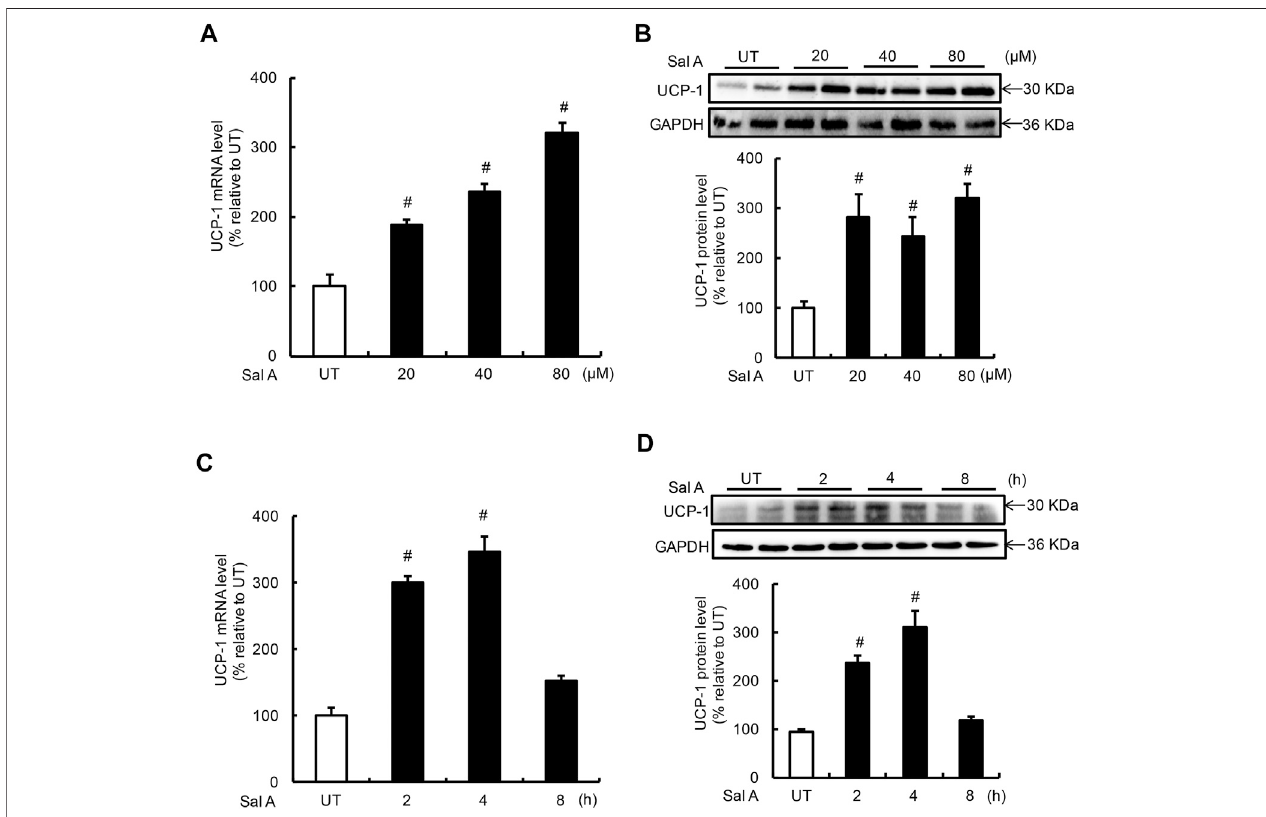
FIGURE1| SalAtreatmentinducedUCP-1expressioninadipocytes. (A,B) DifferentiatedC3H10T1/2adipocytesweretreatedwithSalA(0,20,40,and80 μ M)for 4 h,intracellularUCP-1contentwasdeterminedbyRT-PCRandWesternblot,respectively. (C,D) Time-coursechangesofintracellularmRNAandproteinlevelsofUCP- 1 were determined on Sal A (80 μ M) treatment with different duration (0, 2, 4, and 8 h). All values are denoted as means ± SD from three independent batches of cells. # p < 0.05 vs. the UT. All groups contain two or three samples ( n (cid:1) 2 or n (cid:1) 3).